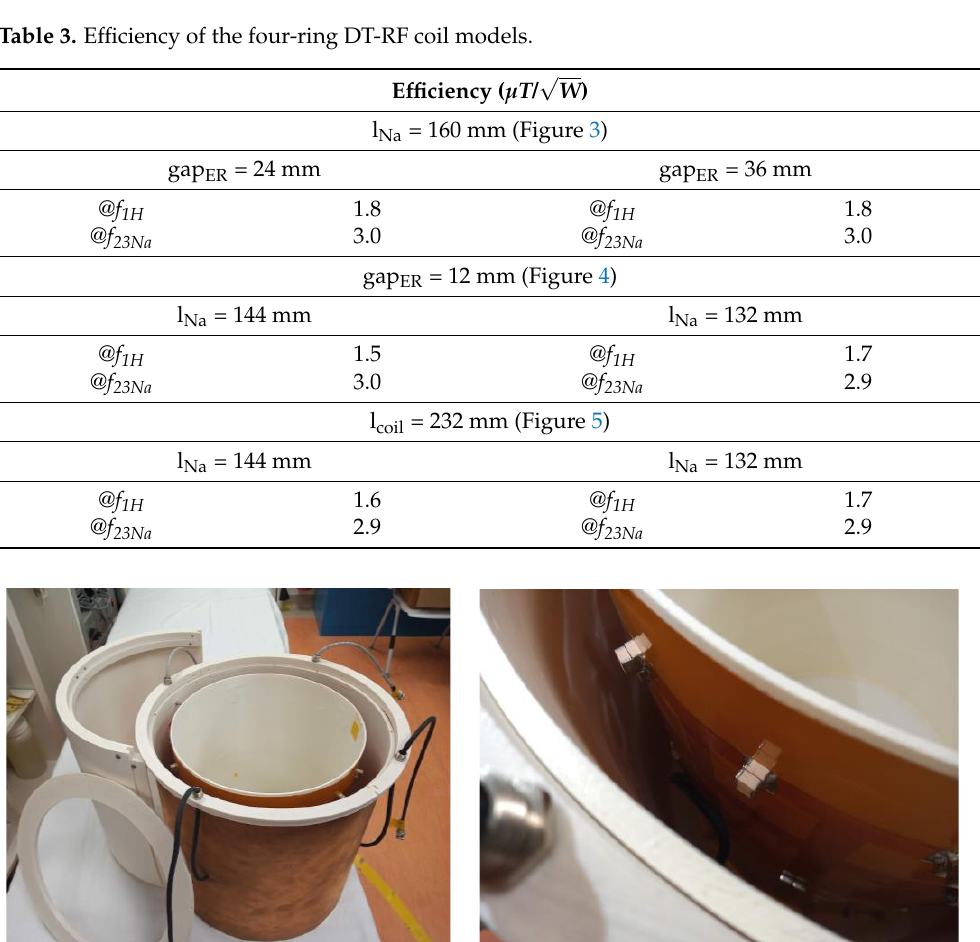
Figure 10 . The four-ring DT-RF prototype view after removing the external case ( left ). Detail of the coil structure with two of the four rings visible ( right ).